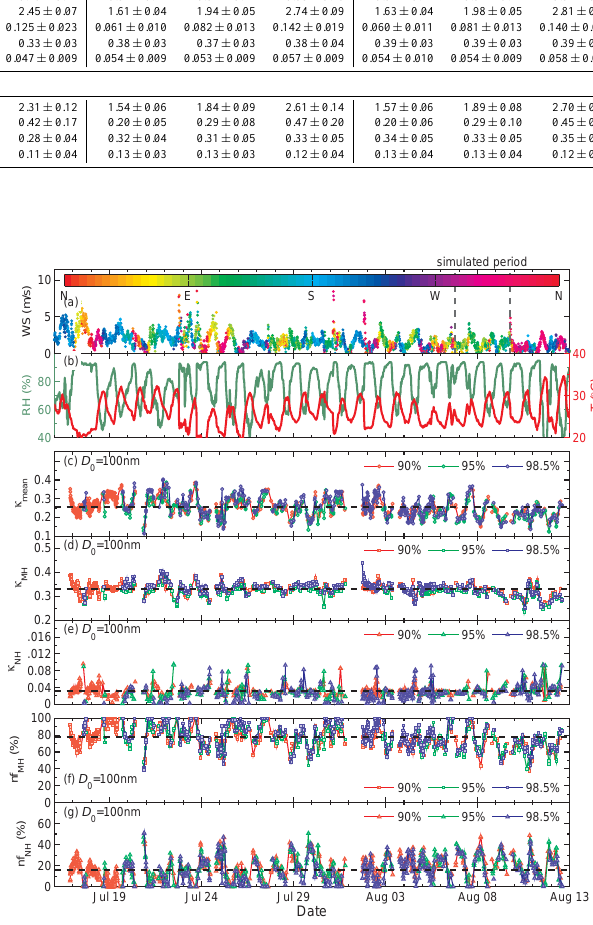
Fig. 3. Time series of meteorological parameters and hygroscopic properties of 100nm particles in the HaChi summer campaign. (a) : wind speed and wind direction; (b) temperature (T ) and relative humidity (RH); (c) : mean κ (averaged over both modes, 100nm dry diameter); (d) : κ of more-hygroscopic group particles; (e) : κ of nearly-hydrophobic mode particles; (f) : number fraction of more-hygroscopic group particles; (g) : number fraction of nearly- hydrophobic group. The dashed lines represent the average value of each